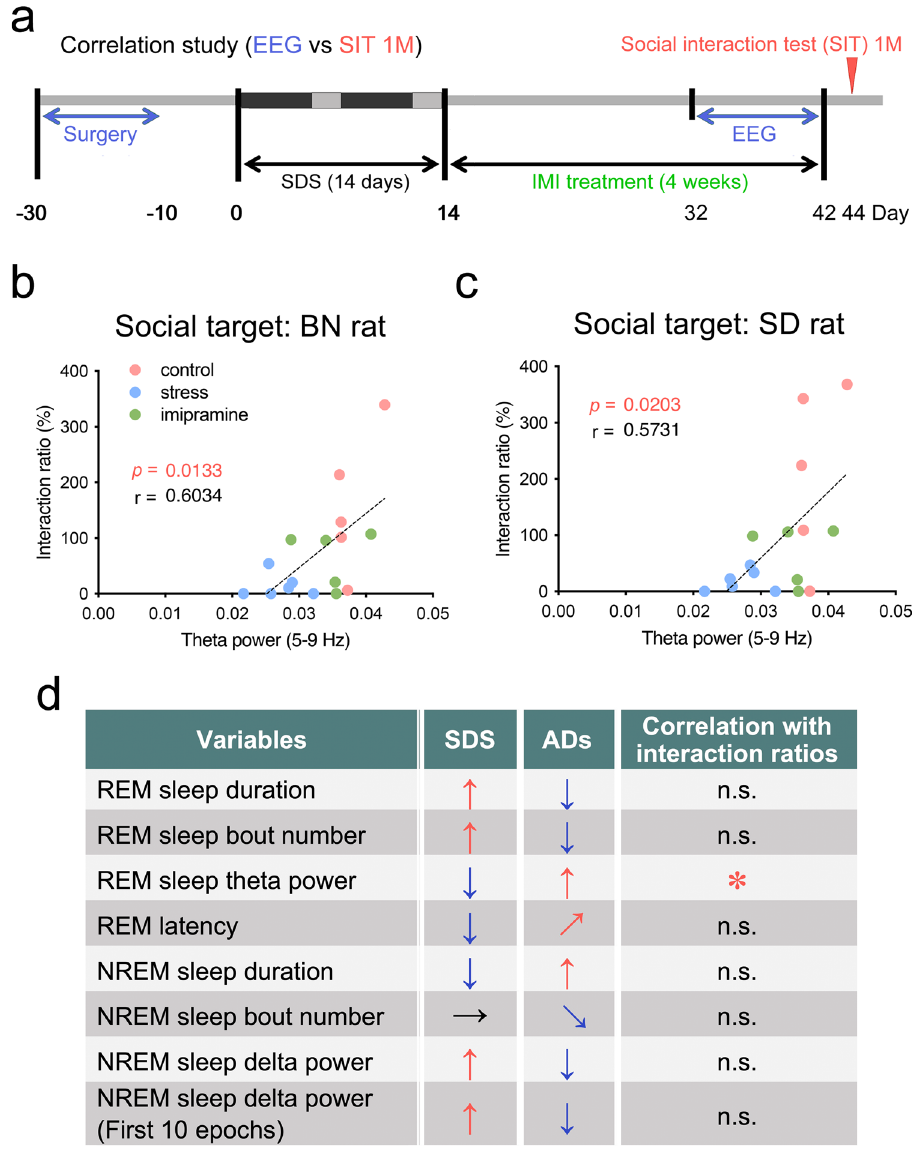
Figure 5. Correlations between the rapid eye movement (REM) sleep theta power and interaction ratios 1 month after the last social defeat stress (SDS). ( a ) Experimental schedule for correlation analysis. ( b , c ) Correlations between the average relative REM theta power during the light phase (ZT0–ZT8.5) and interaction ratios with social targets (BN rats; b , SD rat; c ) 1 month after the last SDS. ( d ) Summary of the correlation